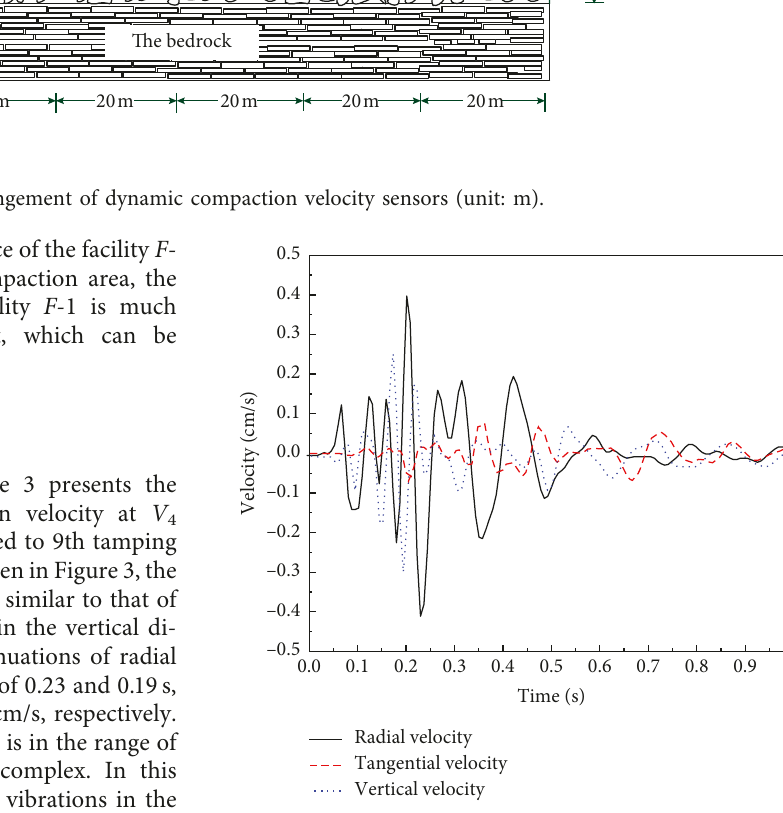
Figure 3: Waveforms of vibration velocity at 80m